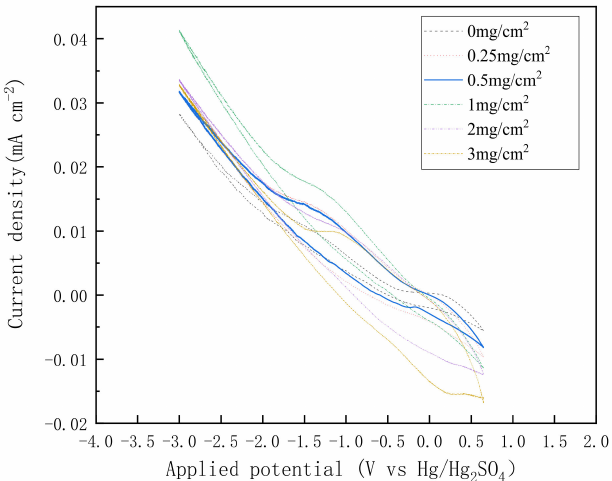
Figure 6. Cyclic voltammogram (CV) curves of Pd/CF, electrolyte of 30 mM CH 3 COONa, scan rate of 0.03 V/s, number of the scans 6, and 1 mM